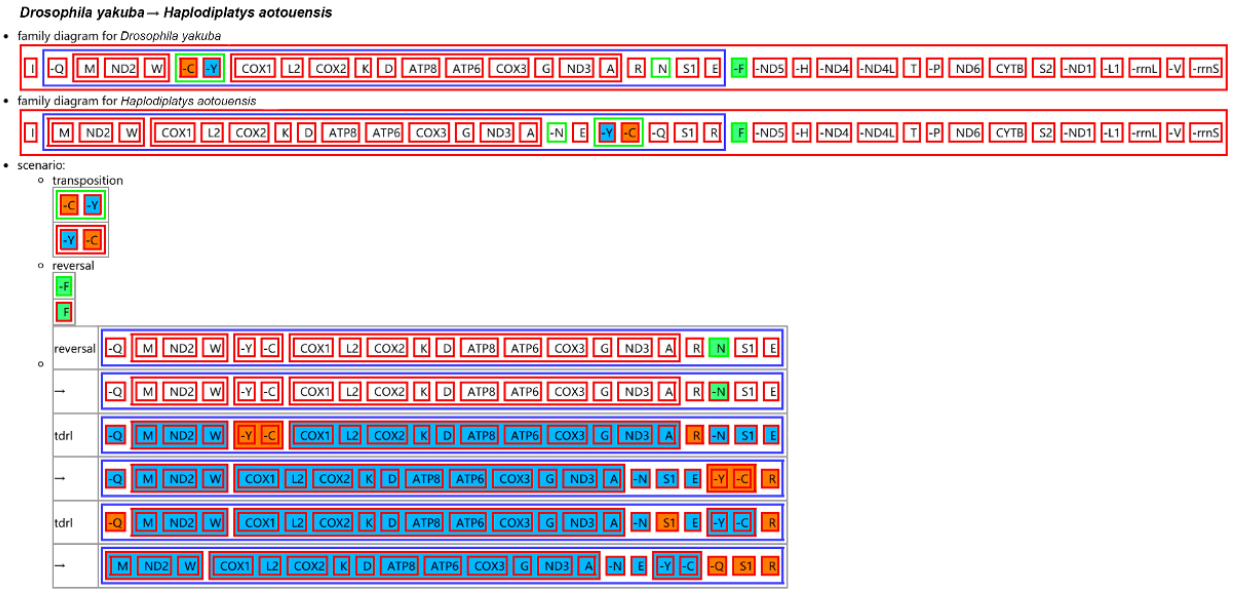
Figure 2. Reconstruction of mitochondrial gene rearrangement scenarios in the evolution of Hap- lodiplatys aotouensis . The ancestral mitochondrial gene arrangement of Drosophila yakuba is set as the reference. The tRNA genes are represented by the amino acid abbreviations. In each rearrangement event of the scenario, the upper box indicates the earlier arrangement of related genes, whereas the lower box indicates the rearranged gene order after the event.